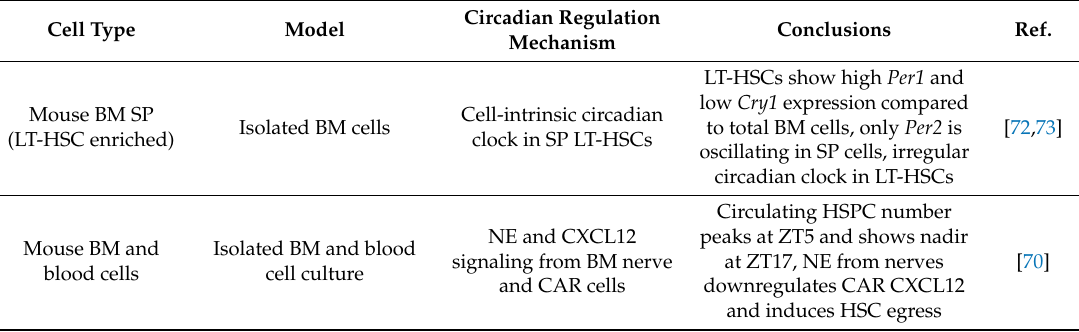
Table 3. Circadian regulation of hematopoietic stem and progenitor cell (HSPC)